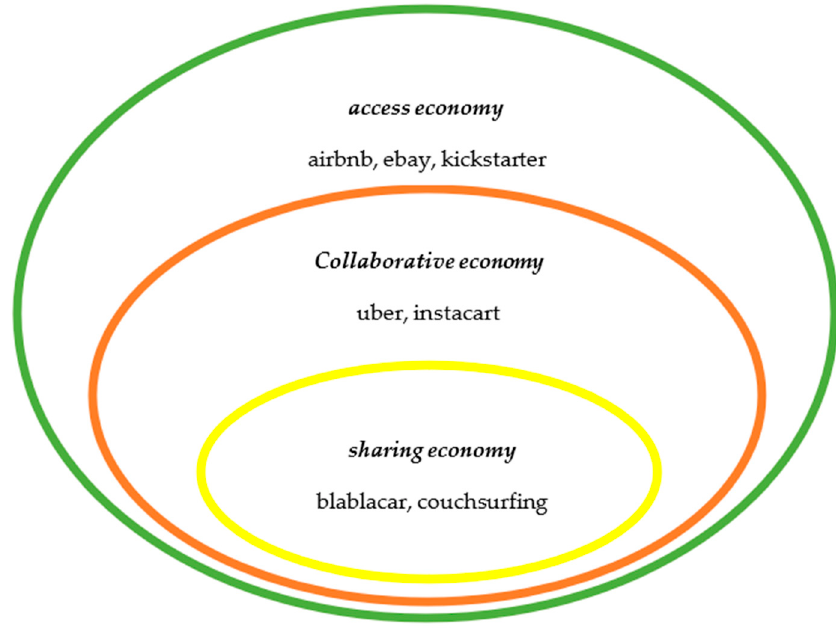
Figure 1. Sharing economy in a broader context. Source: own study based on [23].